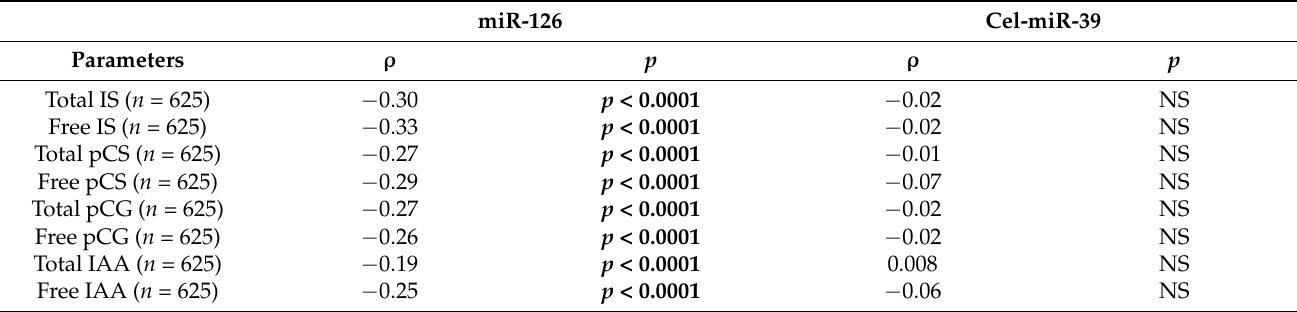
Figure 3. Levels of uremic toxins over the different stages of CKD. * p < 0.05 vs healthy. Abbreviations: NS, non-significant; Table 3. Univariate association of miR-126 and free and total blood levels of uremic toxins (Spearman’s rank correlation IS, indoxyl sulfate; pCS, para-cresyl-sulfate; pCG, p-cresyl glucuronide; and IAA, indole acetic acid. coefficient is indicated by ρ ).